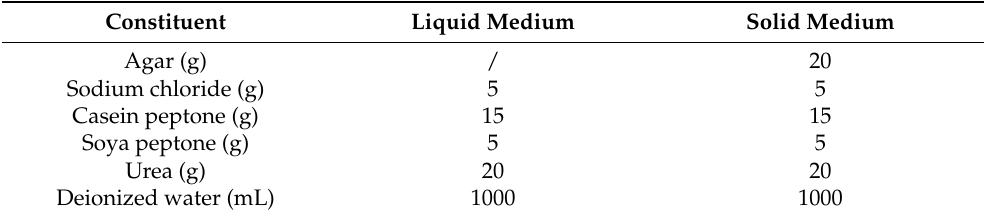
Table 2. Media components.